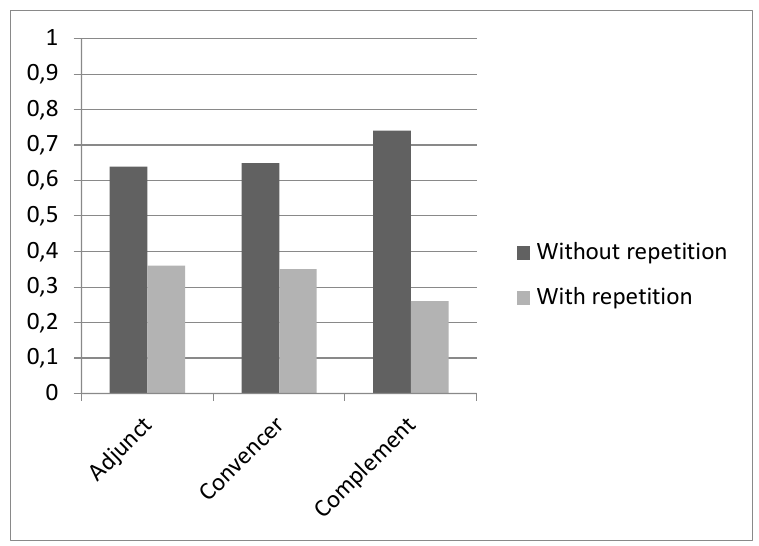
Figure 16. Proportion of repetition for complement, adjunct and convencer - sentences